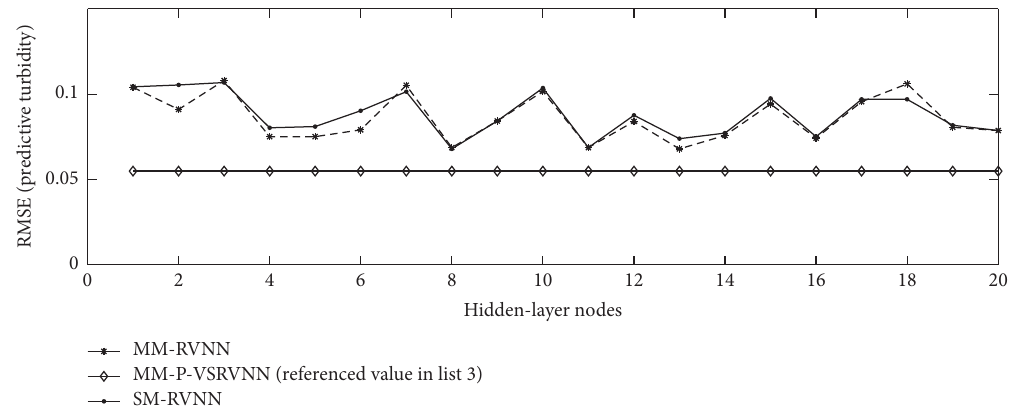
Figure 11: RMSE for predicted turbidity by different algorithms when hidden-layer nodes varied from 1 to